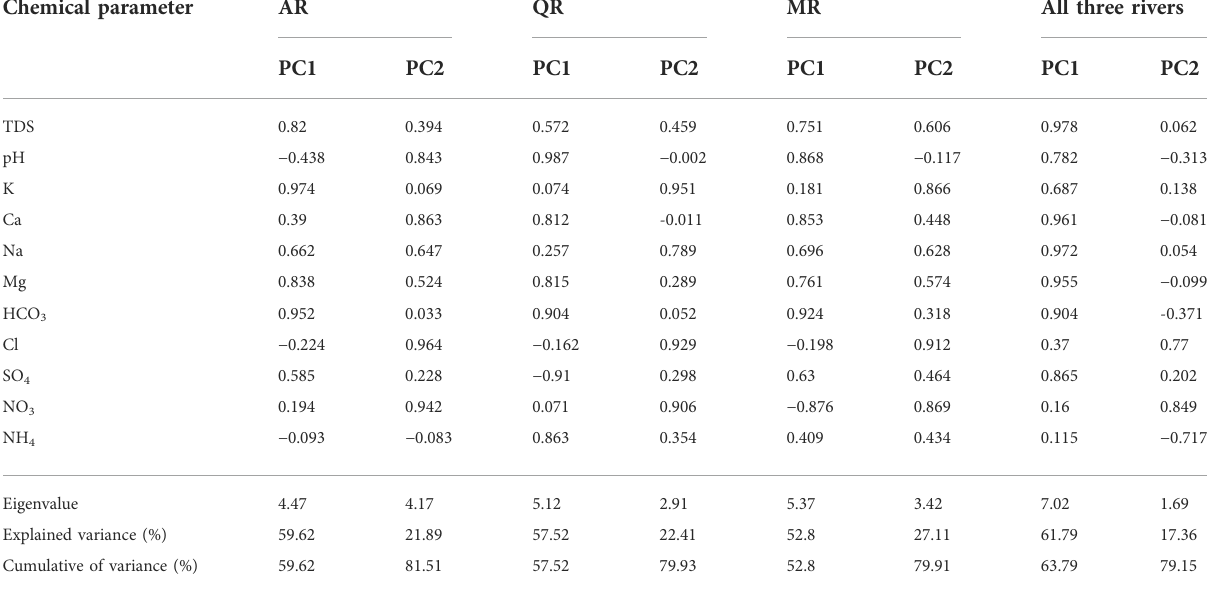
TABLE 2 Principal component loading for water samples in three rivers. Chemical parameter